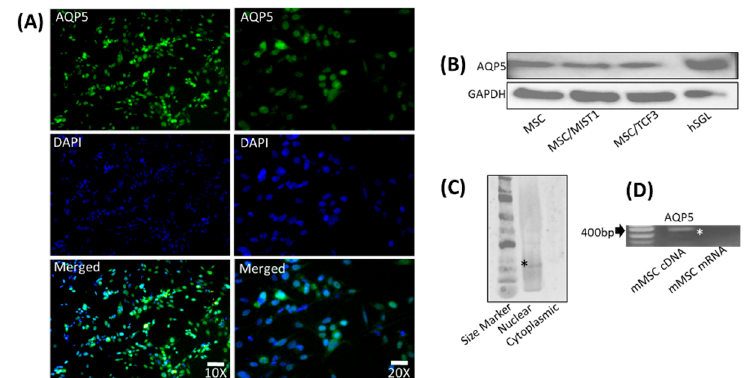
Figure 4. Protein expression of AQP5 in mMSCs localized to the nucleus detected by ICC and WB. ( A ) Ubiquitous expression of AQP5 was detected in mMSCs (green). Images were taken at 100 × and 200 × magnifications. DAPI was used for nuclear staining. Merged images show a co-localization of AQP5 (green) and DAPI in mMSCs. scale bar, 10 and20 µ m. ( B ) WB assay indicated bands representing AQP5 detected equally in MIST1 and TCF3 transfected and untransfected mMSCs, as well as the positive control, hSGL. GAPDH antibody was used for loading control. ( C ) Using Nuclear and cytoplasmic fractionations resolved on a WB, the positive band of AQP5 was detected in the nuclear but not in the cytoplasmic fraction. ( D ) RT-PCR was also performed to confirm mRNA expression of AQP5 in mMSCs. Reverse transcribed cDNA of GAPDH was used as a loading control. (*) indicates the band of